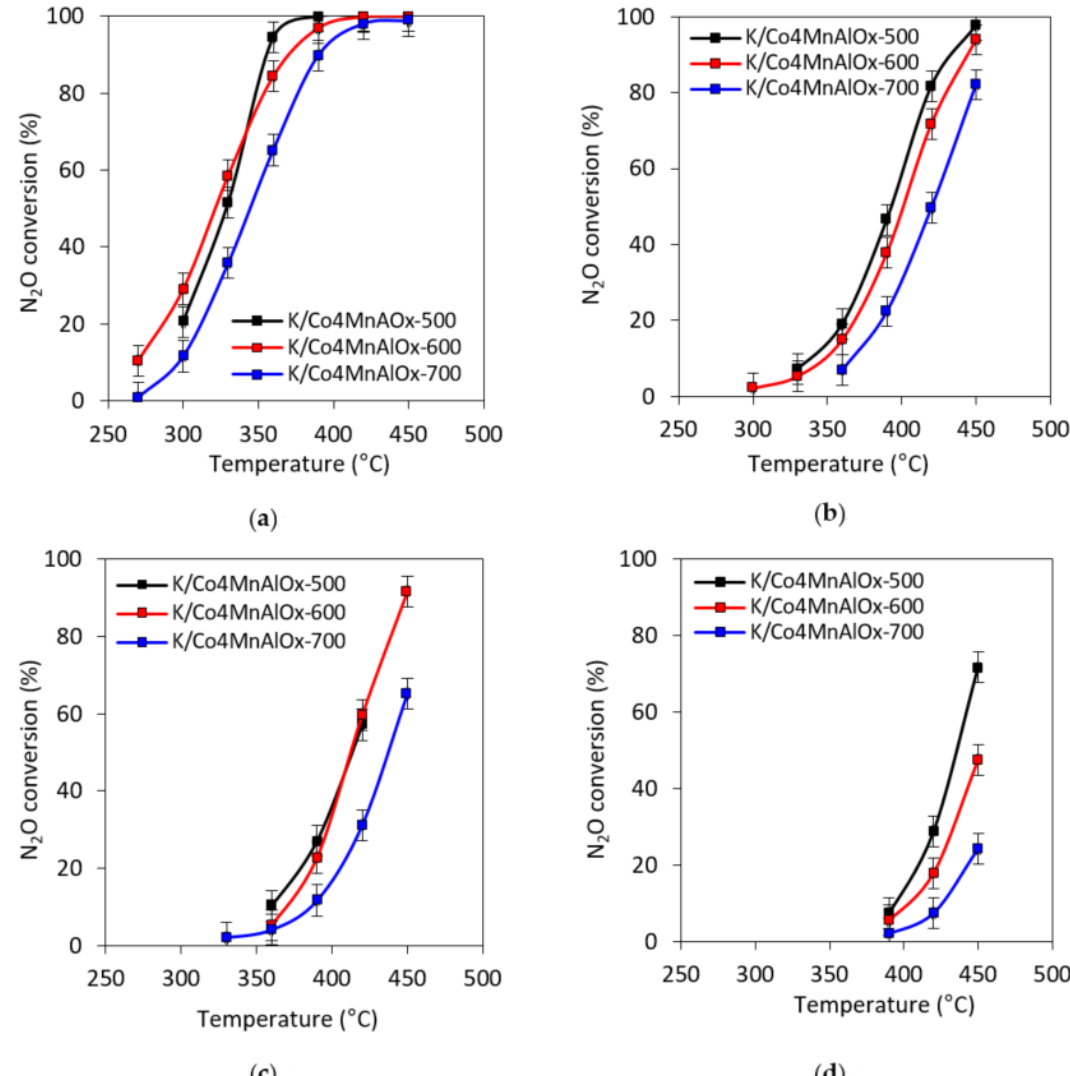
Figure 5. Temperature dependence of N 2 O conversion over K / Co 4 MnAlO x mixed oxide calcined at di ff erent temperatures. Conditions: ( a ) 0.1 mol. % N 2 O balanced by He, ( b ) 0.1 mol. % N 2 O + 5 mol. % O 2 + 0.9 mol. % H 2 O, ( c ) 0.1 mol. % N 2 O + 5 mol. % O 2 + 0.9 mol. % H 2 O + 0.005 mol. % NO balanced by He ( d ) 0.1 mol. % N 2 O + 5 mol. % O 2 + 3 mol. % H 2 O + 0.01 mol. % NO + 0.01 mol. % NO 2 balanced by He, GHSV = 20 L g − 1 h − 1 .